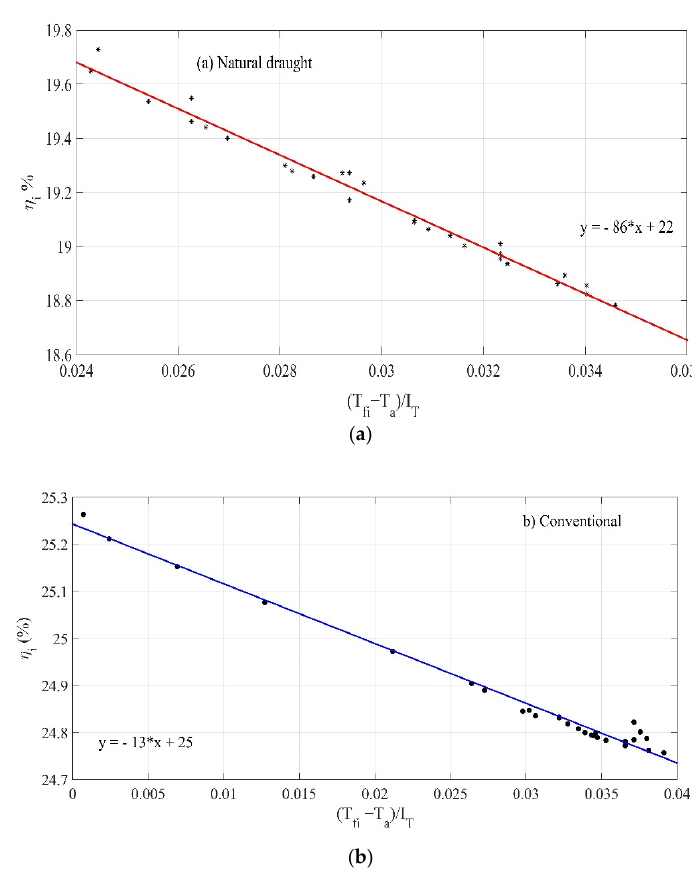
Figure 7. Efficiency curve for solar collectors: ( a ) natural draught; ( b ) conventional.